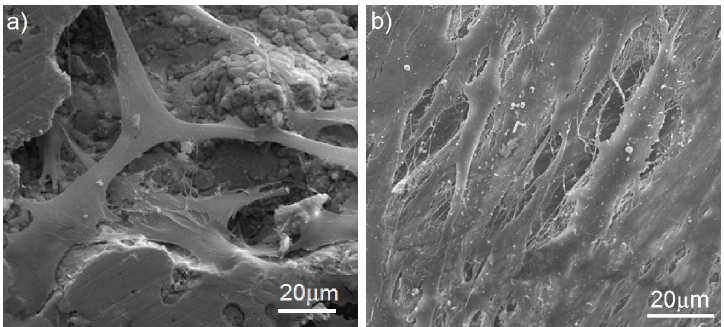
Figure 8. Scanning electron micrograph of osteoblasts cultured on the Ti-10 wt% 45S5